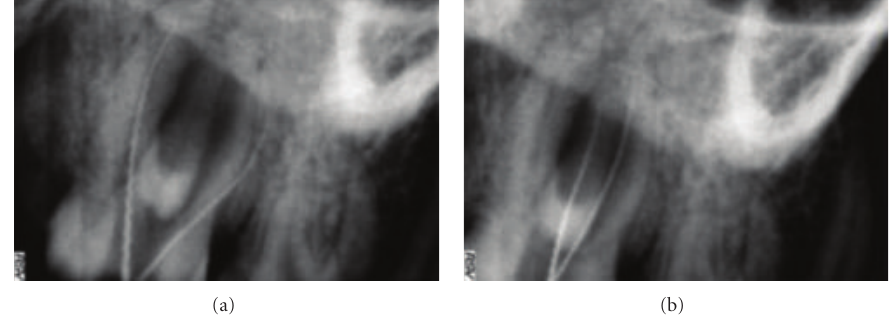
Figure 4: Working length radiograph of di ff erent canals.